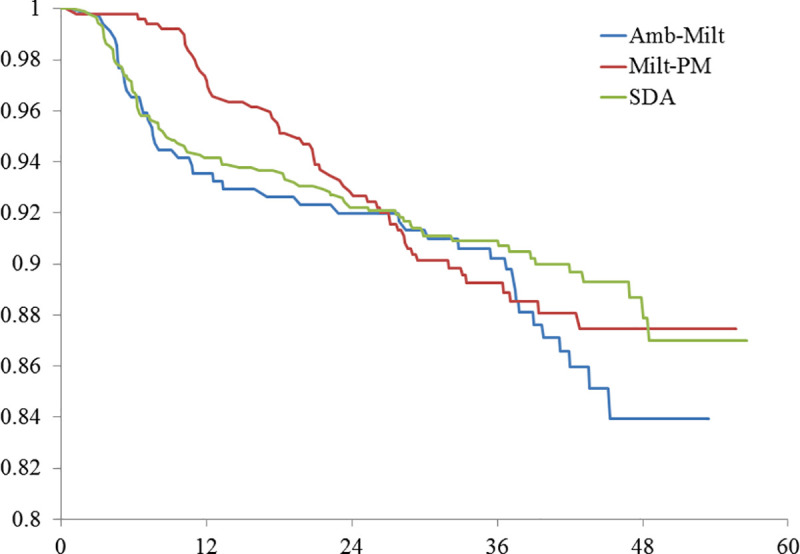
Proportion of study group without either adverse outcome by kala-azar drug regimen by months after treatment.N = 1750. 2 Tail P-value = 0. 7052, Wilcoxon Gehan Test (for early differences.); 2 Tail P-value = 0.5033, Log Rank Test (for later differences).